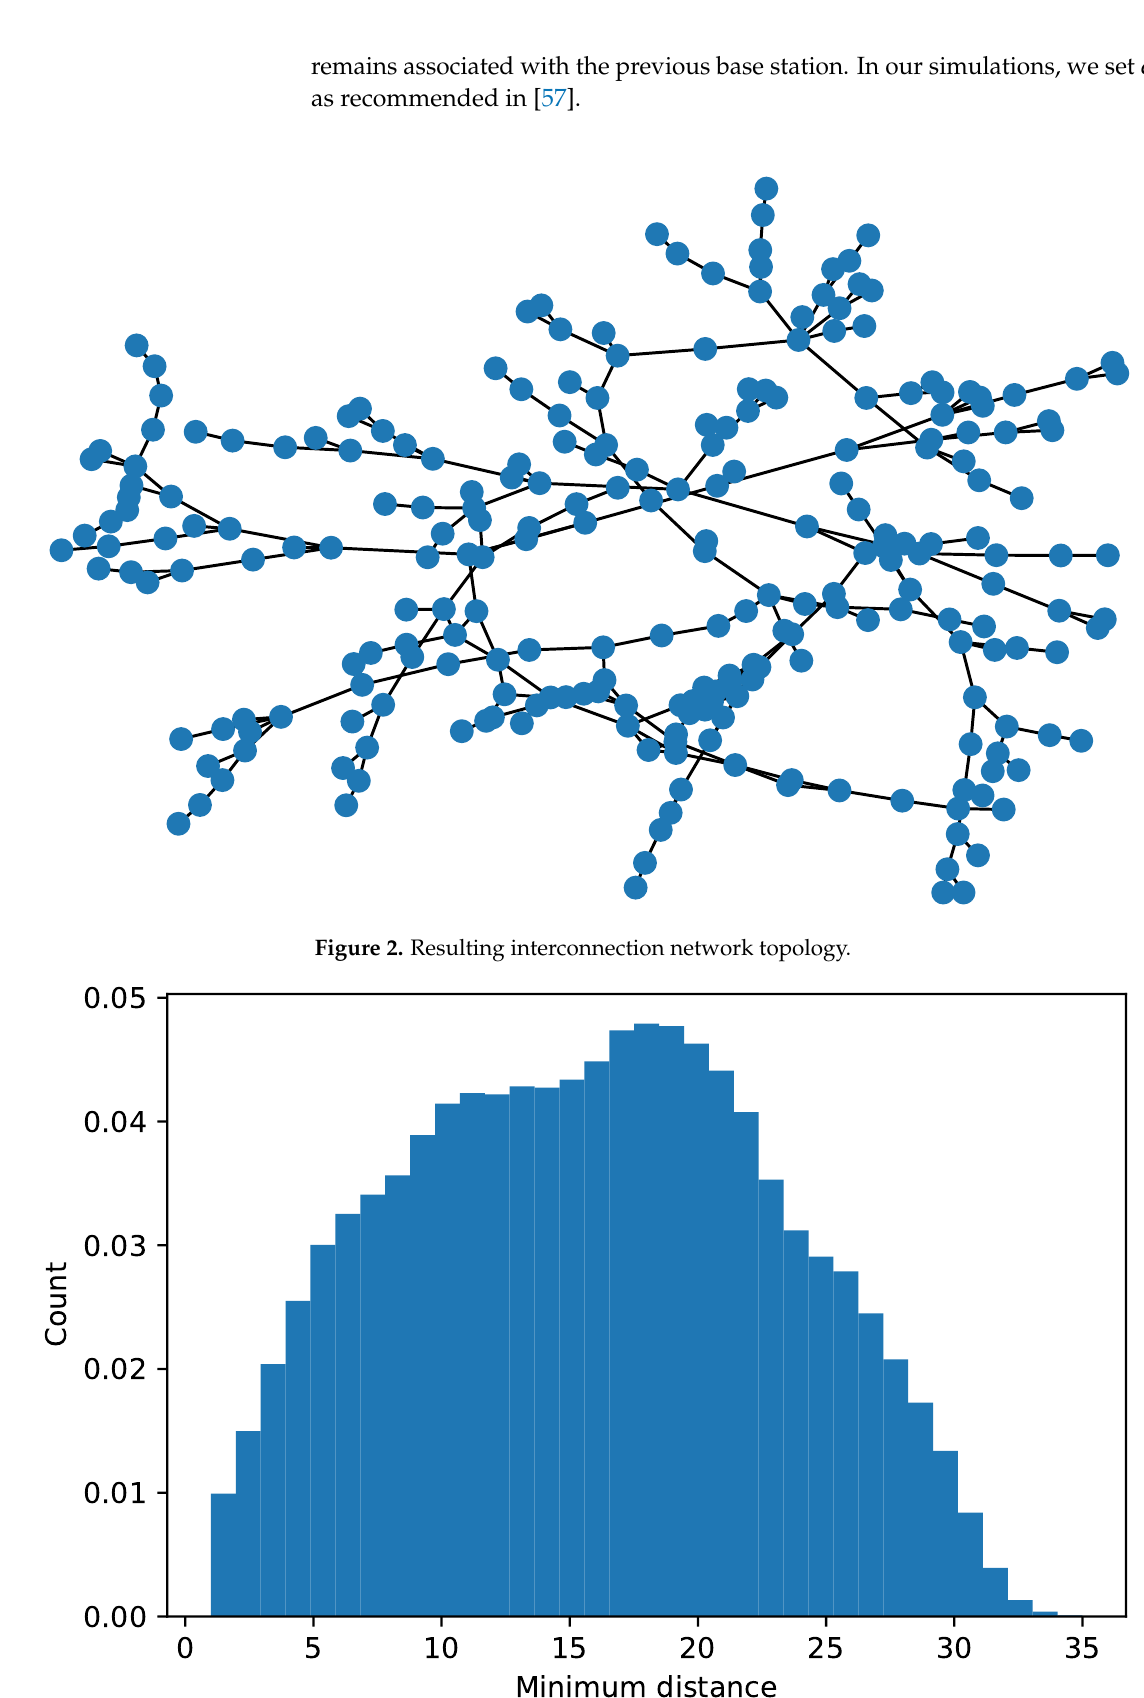
Figure 3. Histogram of the minimum distances (number of hops) between every pair of base stations in the resulting